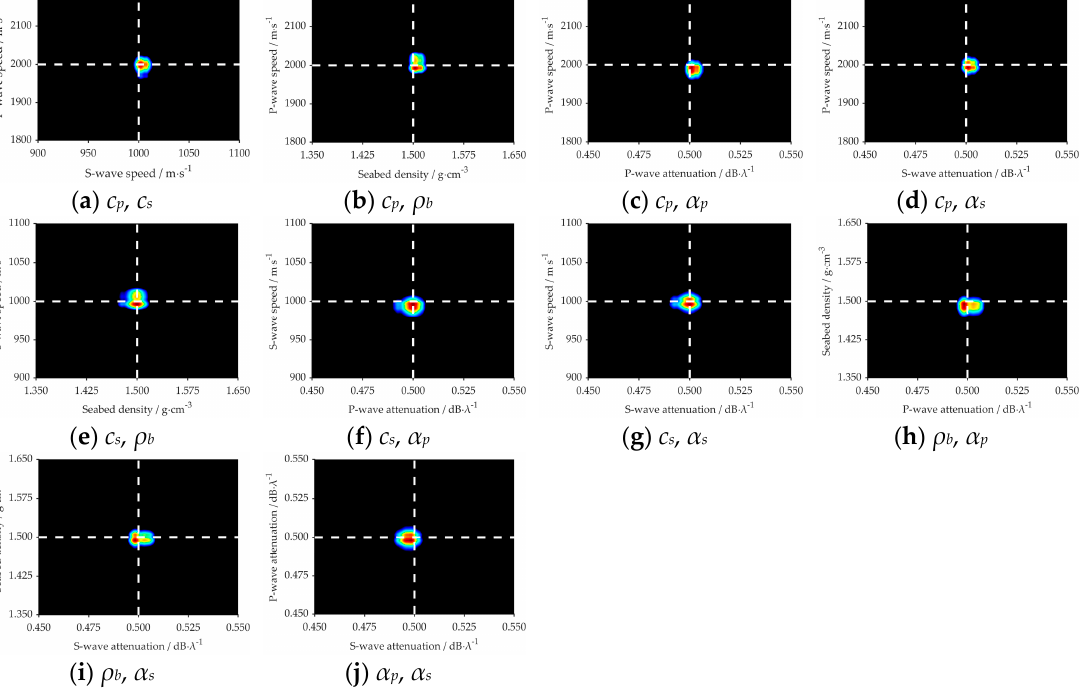
Table 2. Inversion parameter list. The true values, search bounds and inversion values are shown.